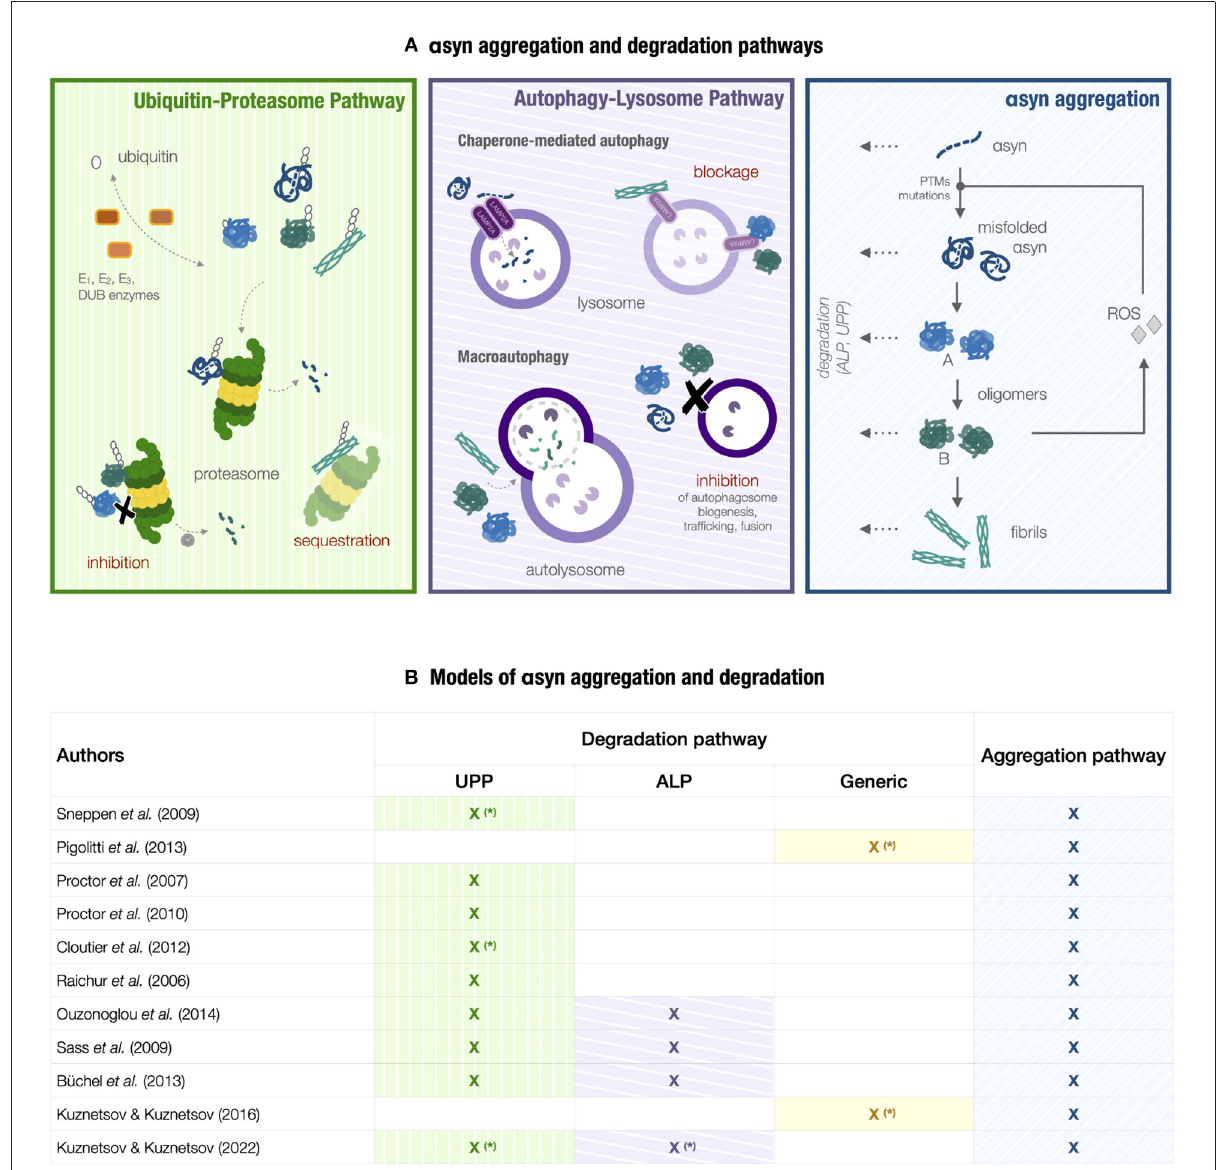
FIGURE2 Models of α syn aggregation and degradation. (A) A conceptual scheme of the PD molecular landscape underlying models in Section 3. A high-level representation of α syn aggregation (light-blue box) is integrated into a more complex network involving the ubiquitin-proteasome pathway (UPP) and the autophagy-lysosome pathway (ALP) (green and purple boxes, respectively), reactive oxygen species (ROS) production, and the corresponding feedback loops. The aggregation process involves α syn misfolding, the conformational change between type-A and type-B oligomers, the conversion from oligomers to fibrils, and degradation of α syn species. Factors triggering α syn misfolding can be post-translational modifications (PTMs), α syn mutations, and high ROS levels. UPP degradation, including ubiquitination and proteasome-mediated degradation, is impaired by fibrils sequestering the proteasome and oligomers inhibiting proteasomal activity either by proteasome overload or directly due to their inherent toxicity. Pathogenic α syn also interferes with ALP components [69]. Fibrils and oligomers can block CMA degradation by obstructing LAMP2A receptors and inhibiting their assembly [67, 85, 125]. Macroautophagy is the main degradation route for α syn aggregates. In return, misfolded α syn and its aggregates can exert an overall inhibitory effect on macroautophagy and hamper its activity by interfering with autophagosome formation, maturation, and trafficking, in addition to lysosomal fusion and transport [126, 127]. (B) Table collecting the models considered in Section 3. The term Generic indicates a generic degradation mechanism, either proteasome or lysosome-mediated. The models denoted by the symbol (*) incorporate degradation mechanisms either as pseudo-first-order reactions or enzymatic reactions; the remaining models are characterized by a more detailed representation of the degradation